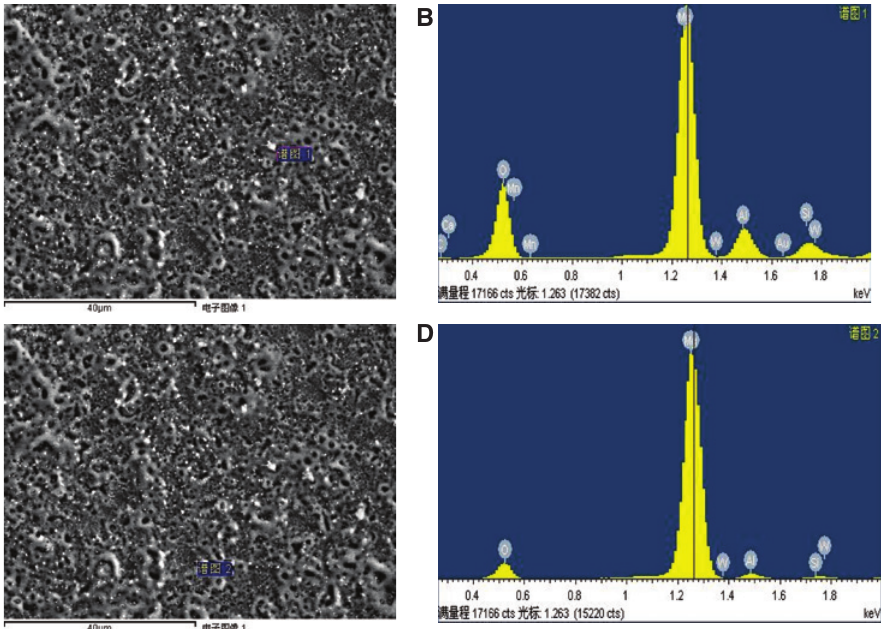
Figure 3 Compound MAO ceramic coating energy spectrum analysis results. (A) EDX spectra of 1. (B) Spectra of one analysis result. (C) EDX spectra of 2. (D) Spectra of two analysis